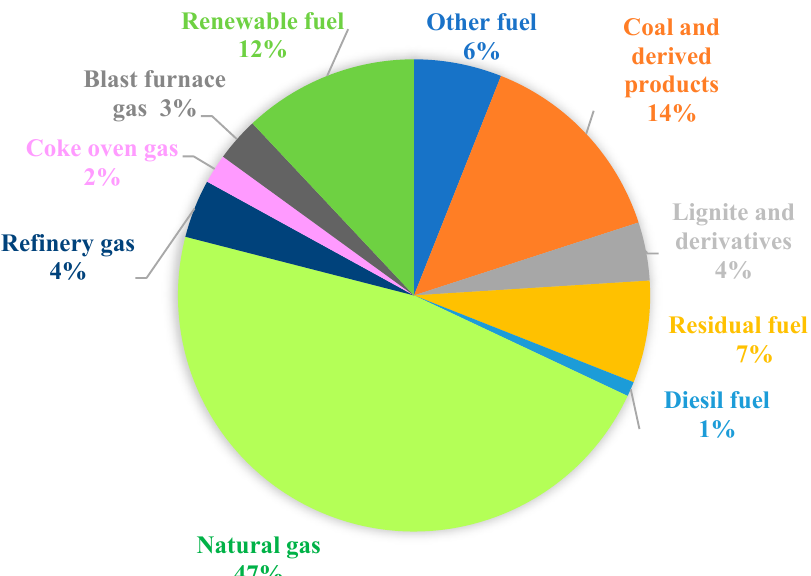
Figure 6. Use of different types of fuel [31].